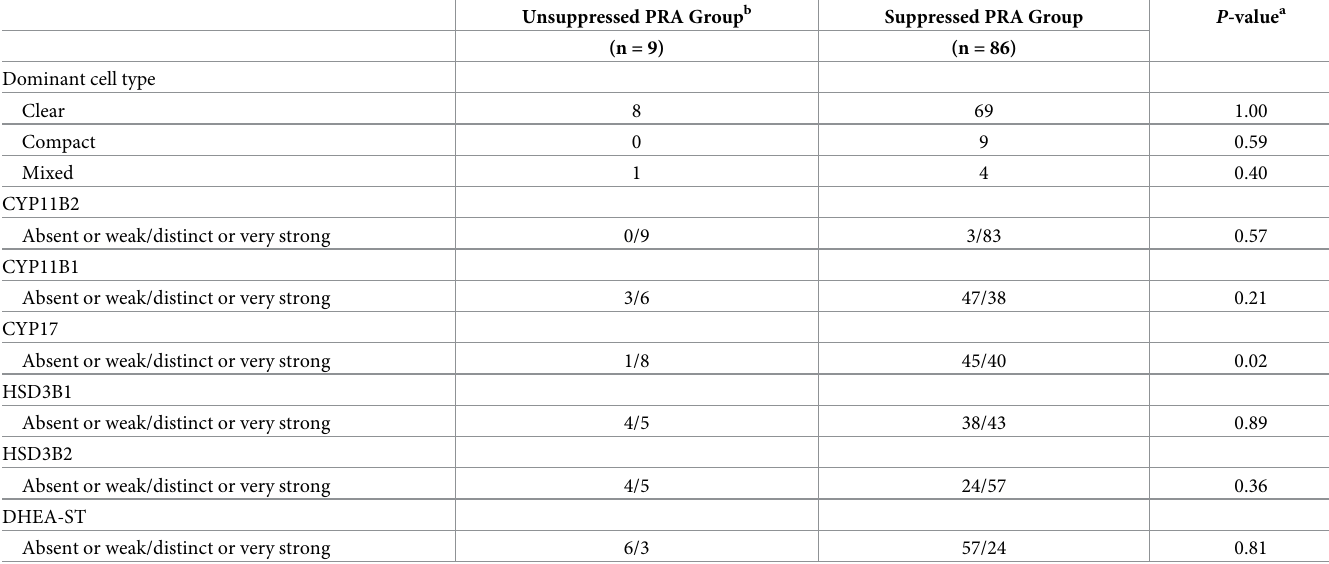
Table 4. Histopathological characteristics in the unsuppressed and suppressed PRA